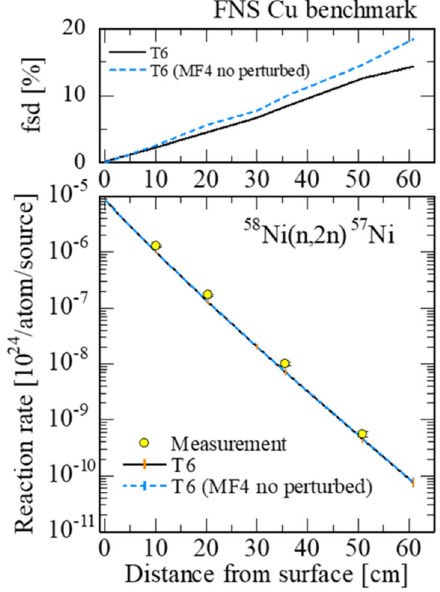
Fig. 5. Comparison of 58 Ni(n,2n) 57 Ni reaction rate distribution and the standard deviation between T6 and the result ignoring perturbation of angular distribution.